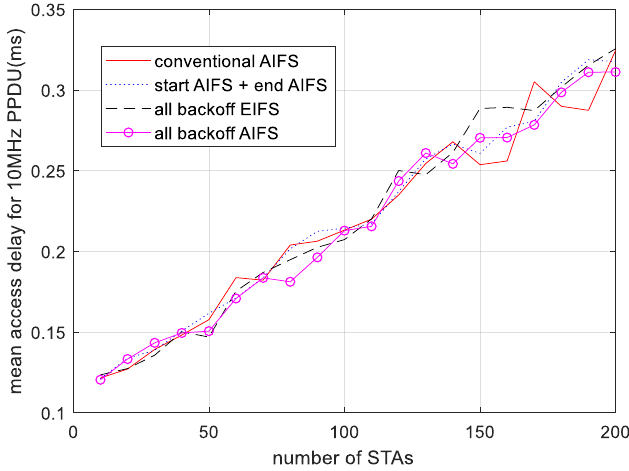
Figure 10. Comparison between channel access schemes under high load in a primary channel.